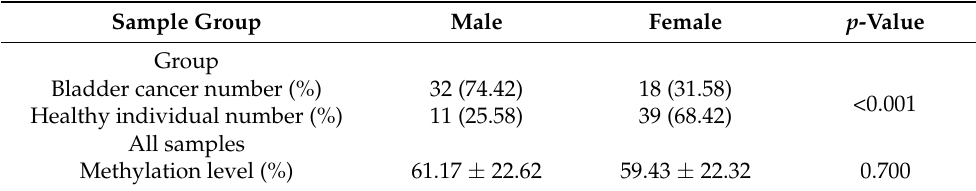
Table 2. Comparison of the sex differences between groups and GSTM5 DNA methylation levels. Table 1. The age and sex of 50 patients with bladder cancer and 50 healthy individuals.